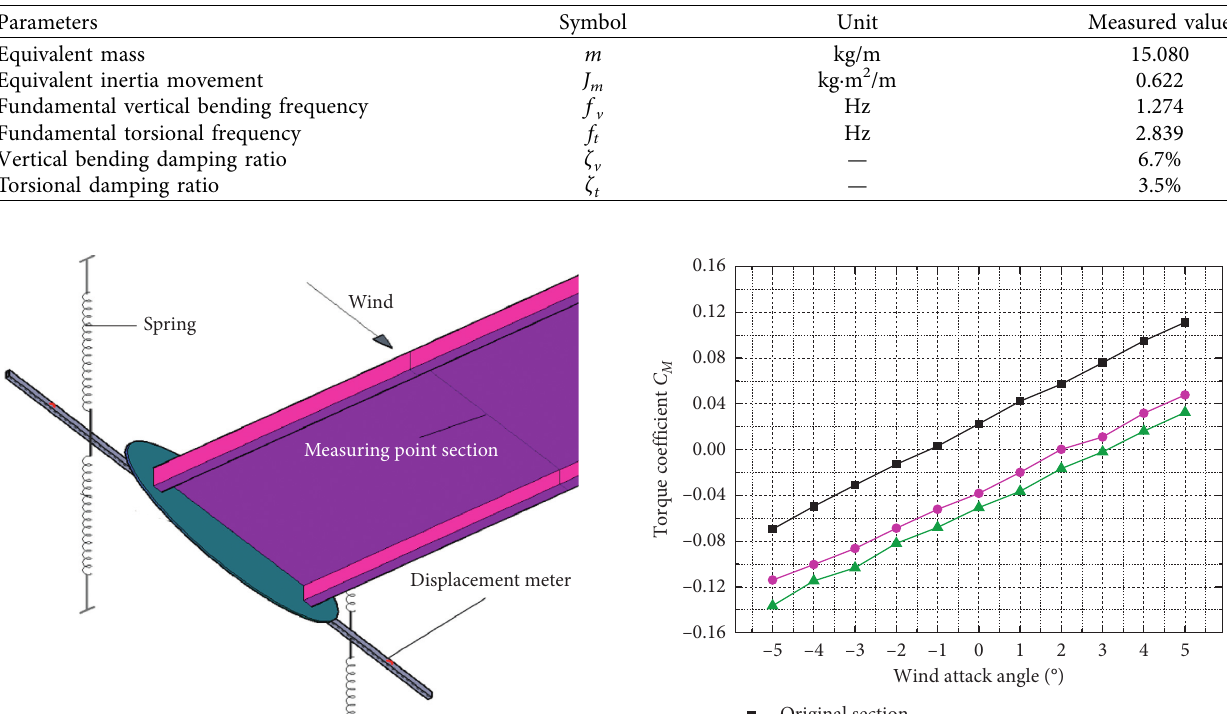
Table 1: Design parameters of the model of the original girder